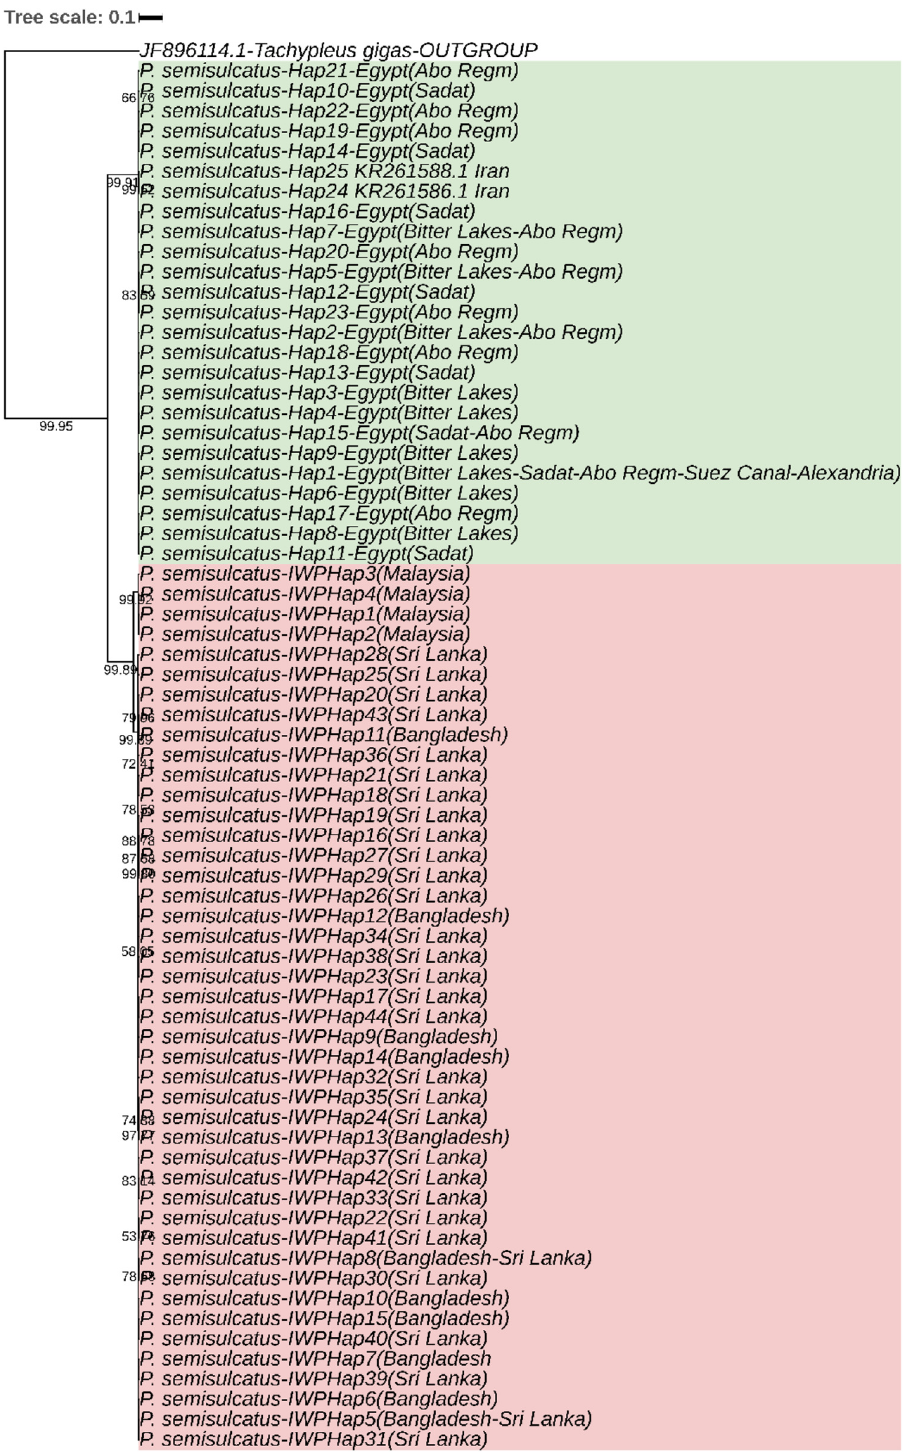
Fig. 7. Maximum-Likelihood (ML) phylogenetic tree for P. semisulcatus world haplotypes (Hap). Posterior probabilities are shown above the branches. Green highlighted: Gulf of Suez P. semisulcatus haplotypes (Hap), and the closely related ones form the Arabian Gulf and the Mediterranean Sea. Red-highlighted: Indo-West Paci fi c (IWP) haplotypes. Tree outgroup: the Southern Horseshoe crab Tachypleus gigas